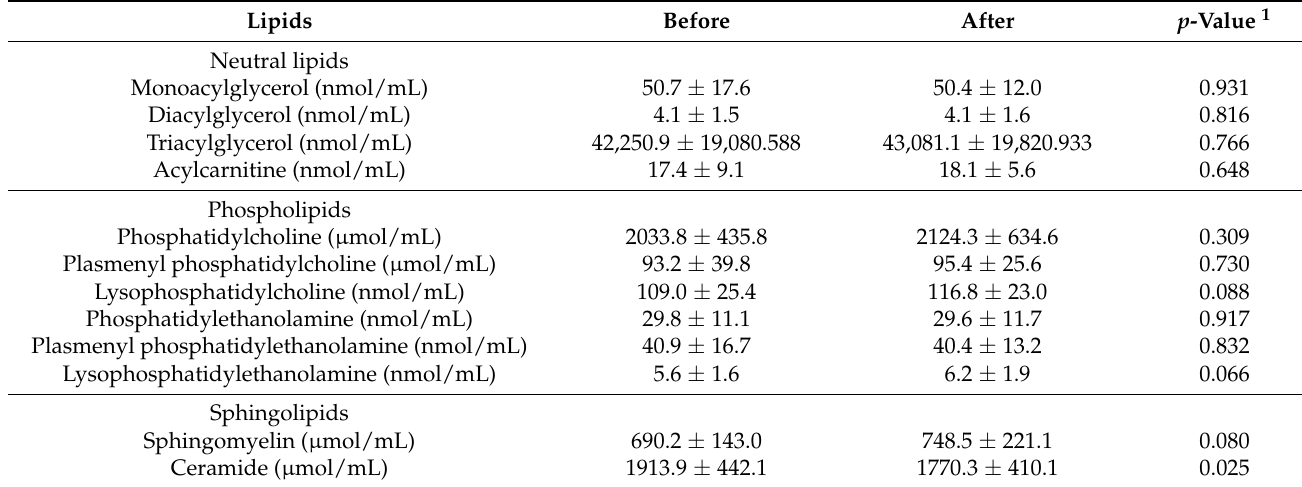
Table 3 shows the serum concentrations of six plasma lipids in the KRG and placebo groups before and after the 4-week study. Among the plasma ceramides, mean changes in the levels of C16 ceramide (d18:1/16:0) and C22 ceramide (d18:1/22:0) were significantly greater in the KRG-intervention group than in the placebo group after adjusting for baseline ceramide levels (d18:1/16:0, 6.4 ± 6.3 pmol/mL vs. 14.6 ± 6.8 pmol/mL, respectively, p = 0.040; and d18:1/22:0, 20.8 ± 24.4 pmol/mL vs. 71.1 ± 26.2 pmol/mL, respectively, p = 0.020). Table 3. Comparison of changes in serum ceramide levels in the KRG and placebo groups before and after the 4-week intervention. Ginseng ( n = 36) Placebo ( n = 32) Pre- Post- Post- ∆ Changes Pre- ∆ Changes p 1 Intervention Intervention Intervention Intervention Ceramides Ceramide (d18:1/16:0)